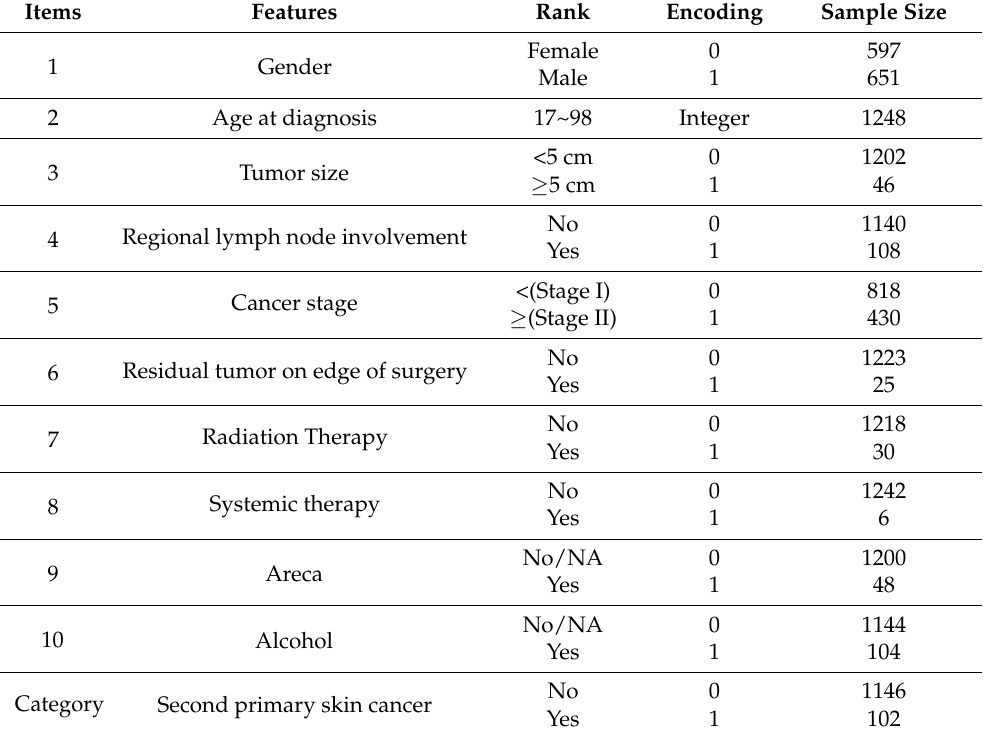
Table 1. Dataset encoding features and sample sizes demonstrated in prediction analysis.